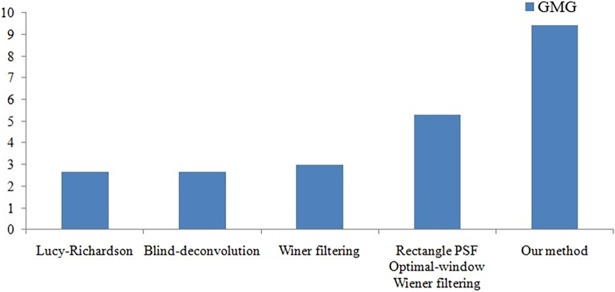
Evaluation of different fusion methods of Fig 4.